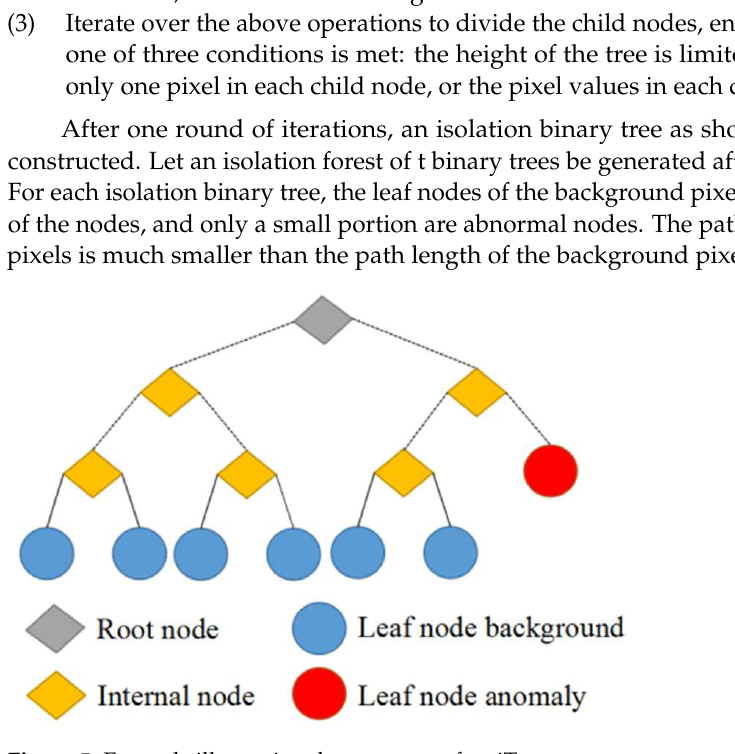
Figure 5. Example illustration the structure of an iTree.